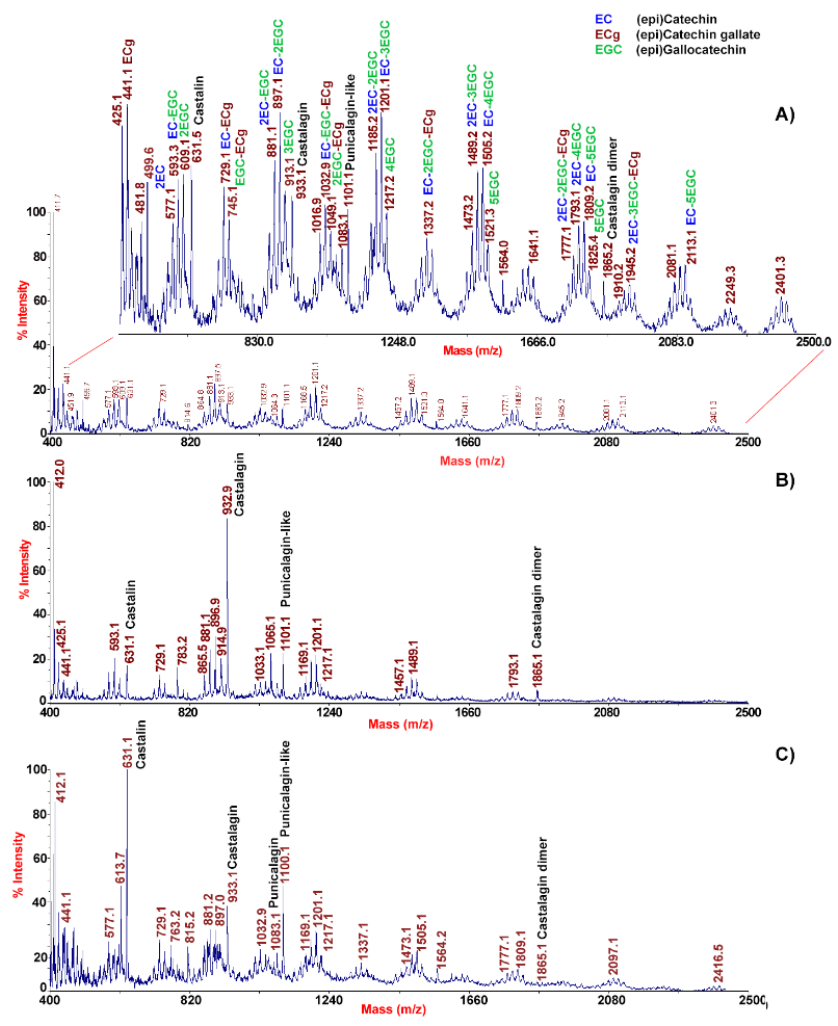
Figure 6. MALDI-TOF mass spectra acquired in linear negative ion mode of wastewater samples resulting from chestnuts subjected to water curing with: (i) tap water containing cultured Lb. pentosus (panel ( A )); (ii) tap water (panel ( B )); (iii) wastewater from a previous curing treatment with tap water (panel ( C )). Condensed polymeric species were ascribed to polyphenols based on MALDI-TOF mass spectra acquired in linear negative ion mode of chestnut pericarp and integument extracts.